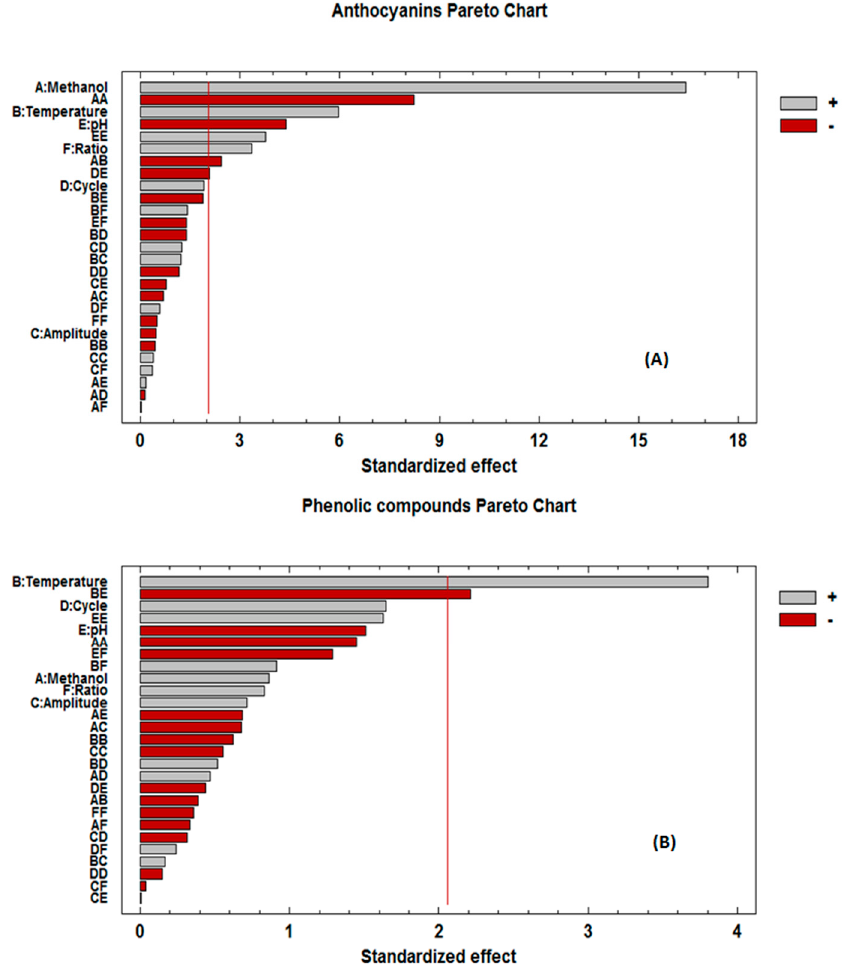
Figure 1. Pareto charts for the standardized effects: ( A ) total anthocyanins and ( B ) total phenolic compounds.